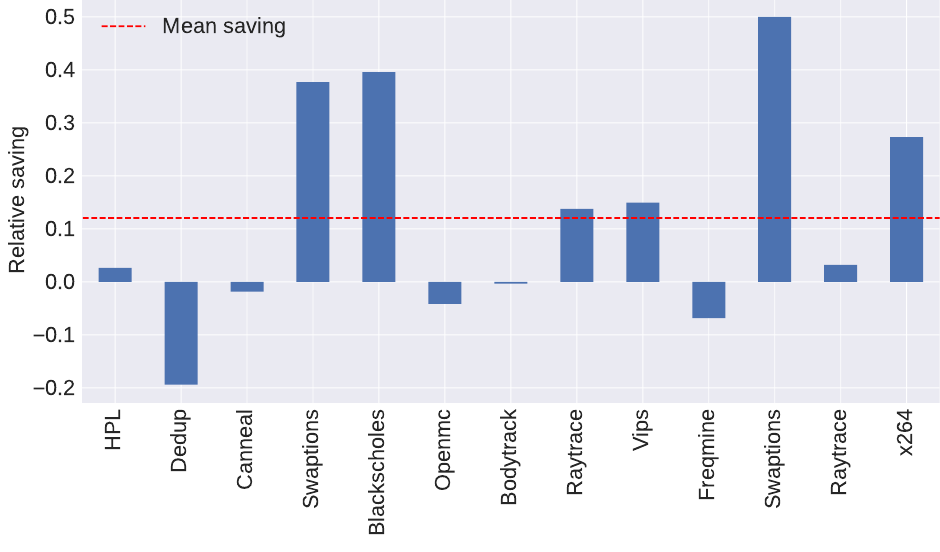
Figure 16. Energy savings comparisons between the proposed model and the Random